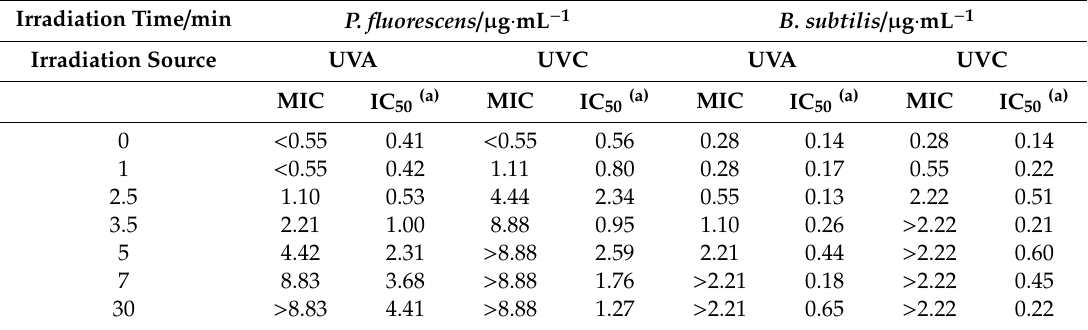
Table 5. MIC values of LOM against P. fluorescens and B. subtilis depending on UVA and UVC irradiation